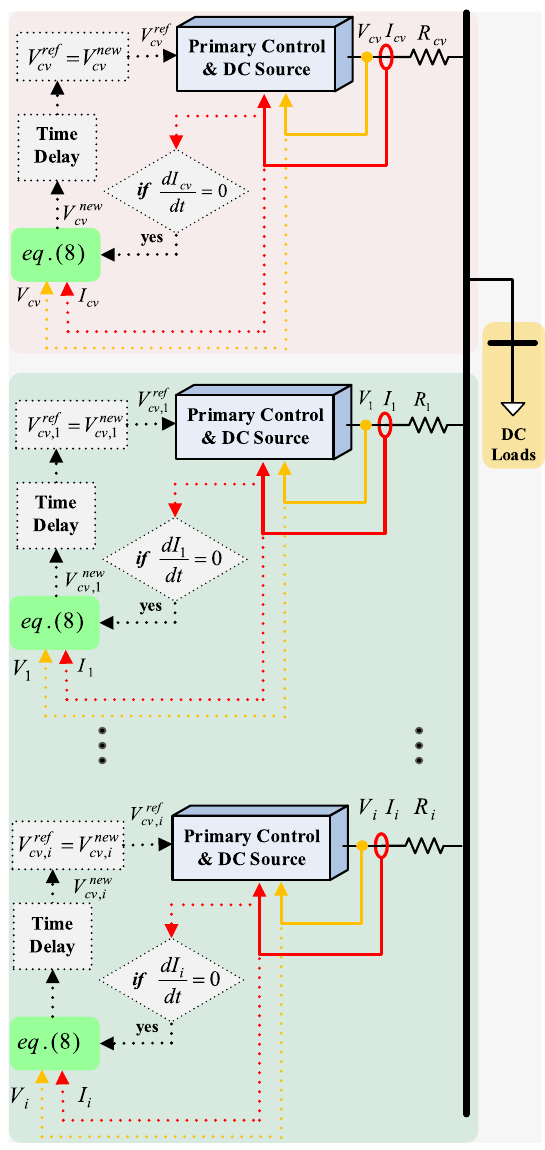
Fig. 4 Block diagram of the proposed secondary control approach without any communication